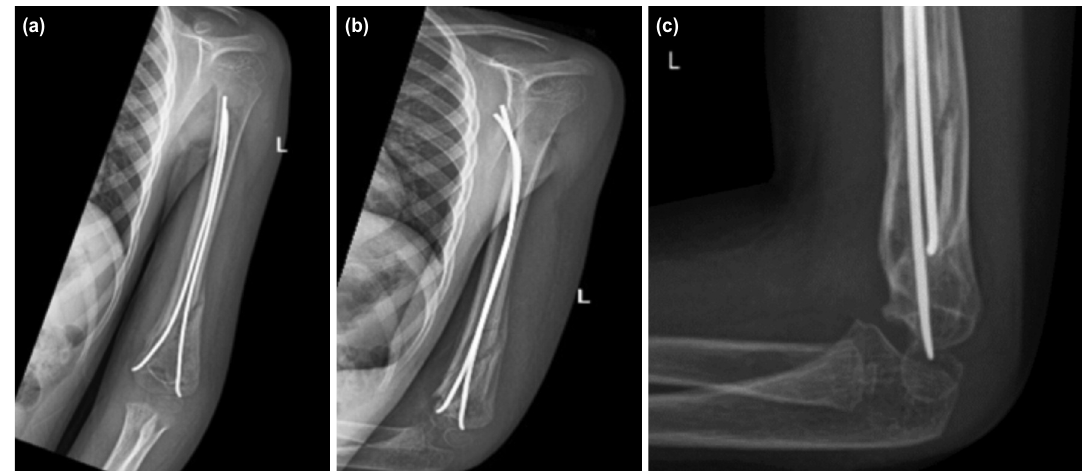
(a) Anteroposterior, (b) oblique and (c) lateral radiographs of the left arm and elbow at three months showing fractures healed Fig. 2: in good